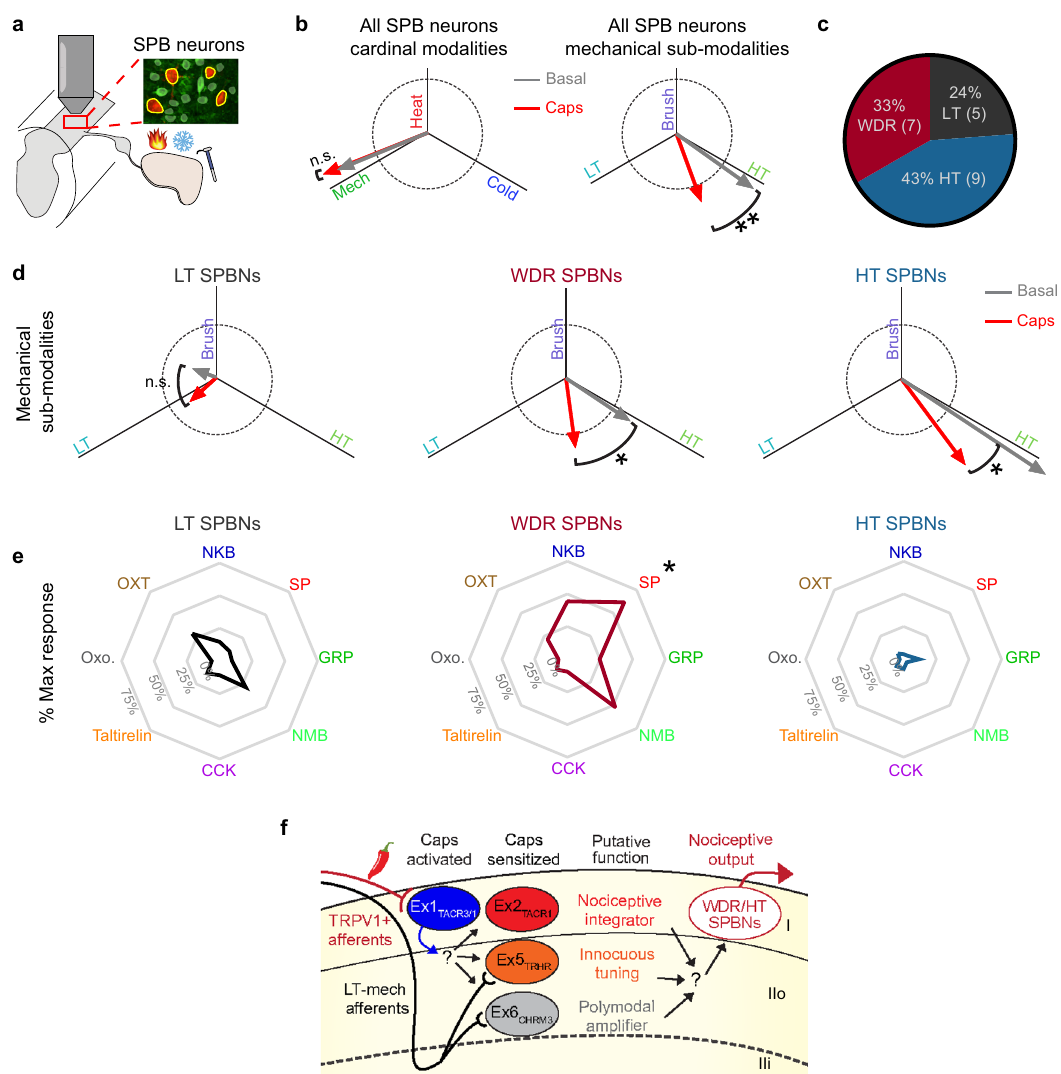
Fig. 8 | Functional classes of SPB neurons show distinct alterations in tuning after central sensitization. a Experimental design. b Left: cardinal modality (left) and mechanical sub-modality (right) tuning of SPB neurons (SPBNs) before (grey) and after capsaicin injection (red). ** P <0.01 (Two-tailed Wilcoxon matched pairs signed rank test comparing angle, P =0.0005). c Pie-chart of the 3 functionally de fi ned classes within SPB neurons. Wide-dynamic range (WDR, Red) SPBNs are de fi ned as those thatresponded to both low and high intensitystimulibut encoded the stimuli intensity in their response amplitude. High-threshold (HT, Blue) SPBNs responded primarily to the 2.0g VF fi lament (HT stimulus). Low-Threshold (LT, Black) SPBNs only responded to brush and/or the 0.16g VF fi lament (LT stimulus). d Mechanical sub-modality tuning of LT (left), WDR (middle), and HT (right) SPBN sub-groups before (grey) and after capsaicin injection (red). Dotted circle is 1 unit